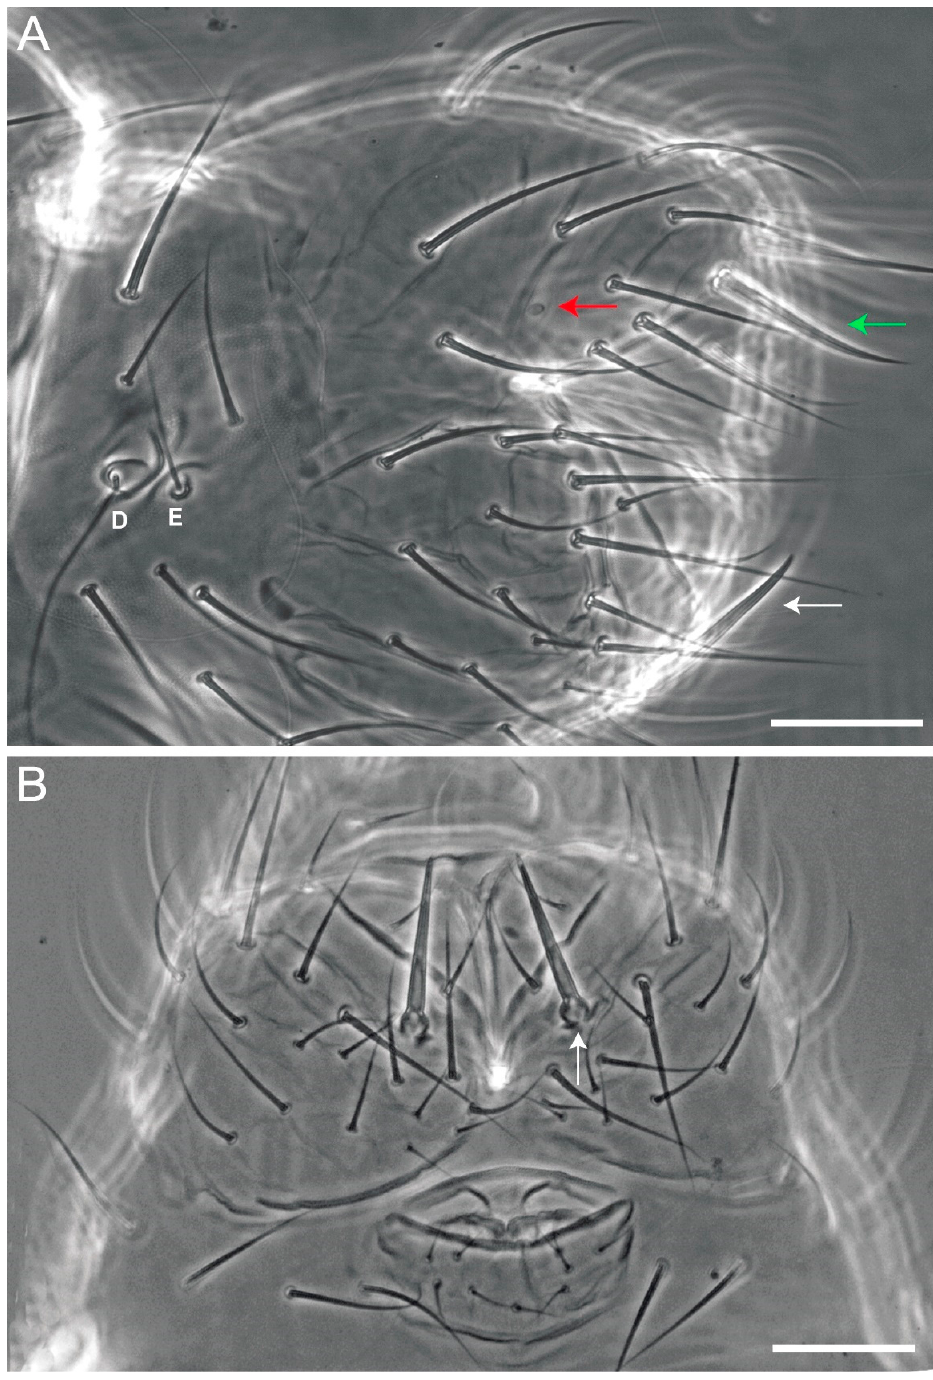
Figure 6. Arlesminthurus caatinguensis sp. nov. female structures. ( A ) Small abdomen (lateral view); D and E represent the bothriotricha, the red arrow an oval organ, the green arrow a robust extra spine ‐ like chaeta on the superior lobe of the Abd VI, and the white arrow the subanal appendage ( mi5 ) on the inferior lobe of the Abd VI. ( B ) Small abdomen and genital plate (ventral view); white arrow shows the subanal appendage ( mi5 ). Scale bars: 0.04 mm.